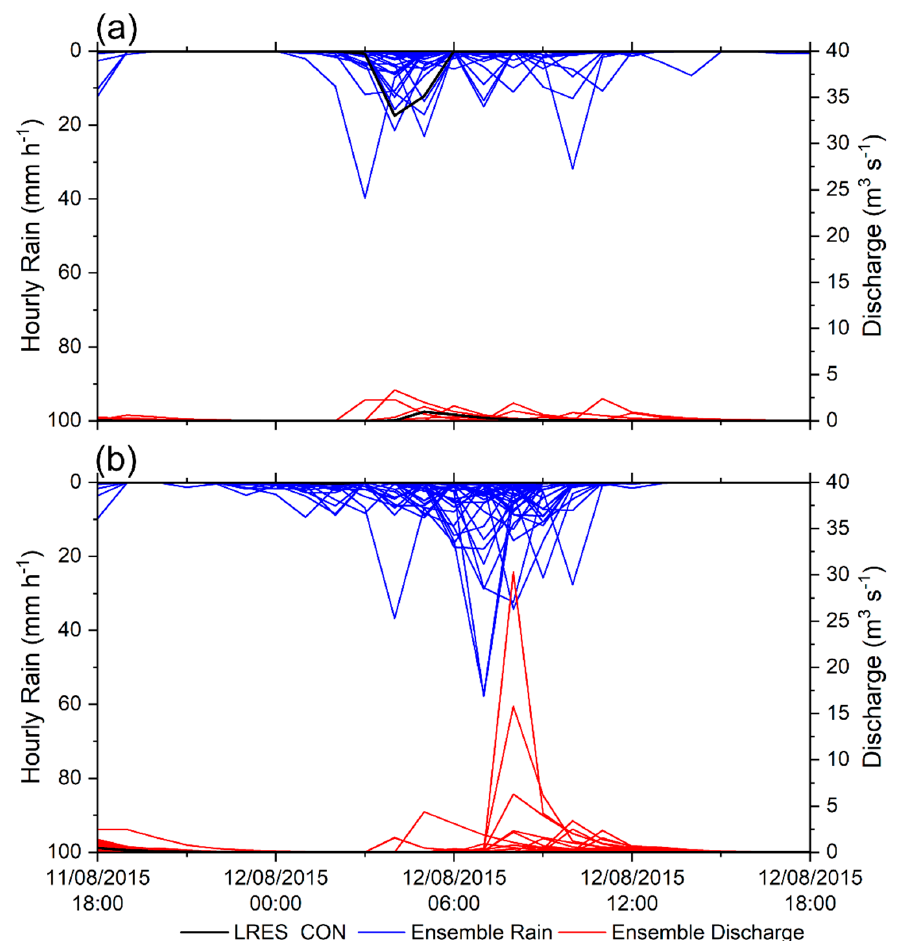
Figure 8. Hourly accumulated rainfall averaged over the Citrea creek catchment with the ensemble low-resolution control forecast and the 50 perturbed ensemble forecasts, and resulting hydrographs: ( a ) forecasts starting at 0000 UTC, 11 August 2015; ( b ) forecasts starting at 1200 UTC, 11 August 2015.